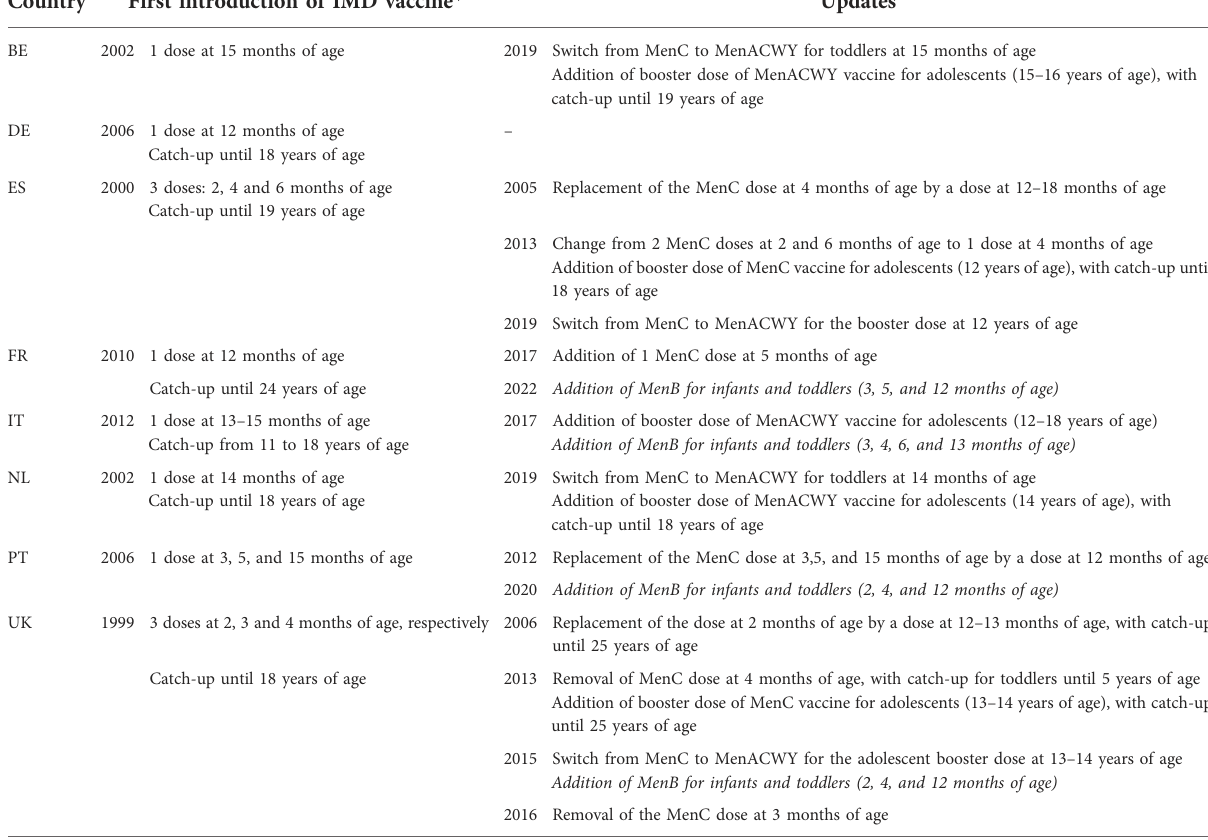
TABLE 2 Introduction of meningococcal vaccines in the national vaccination programs and changes over time.